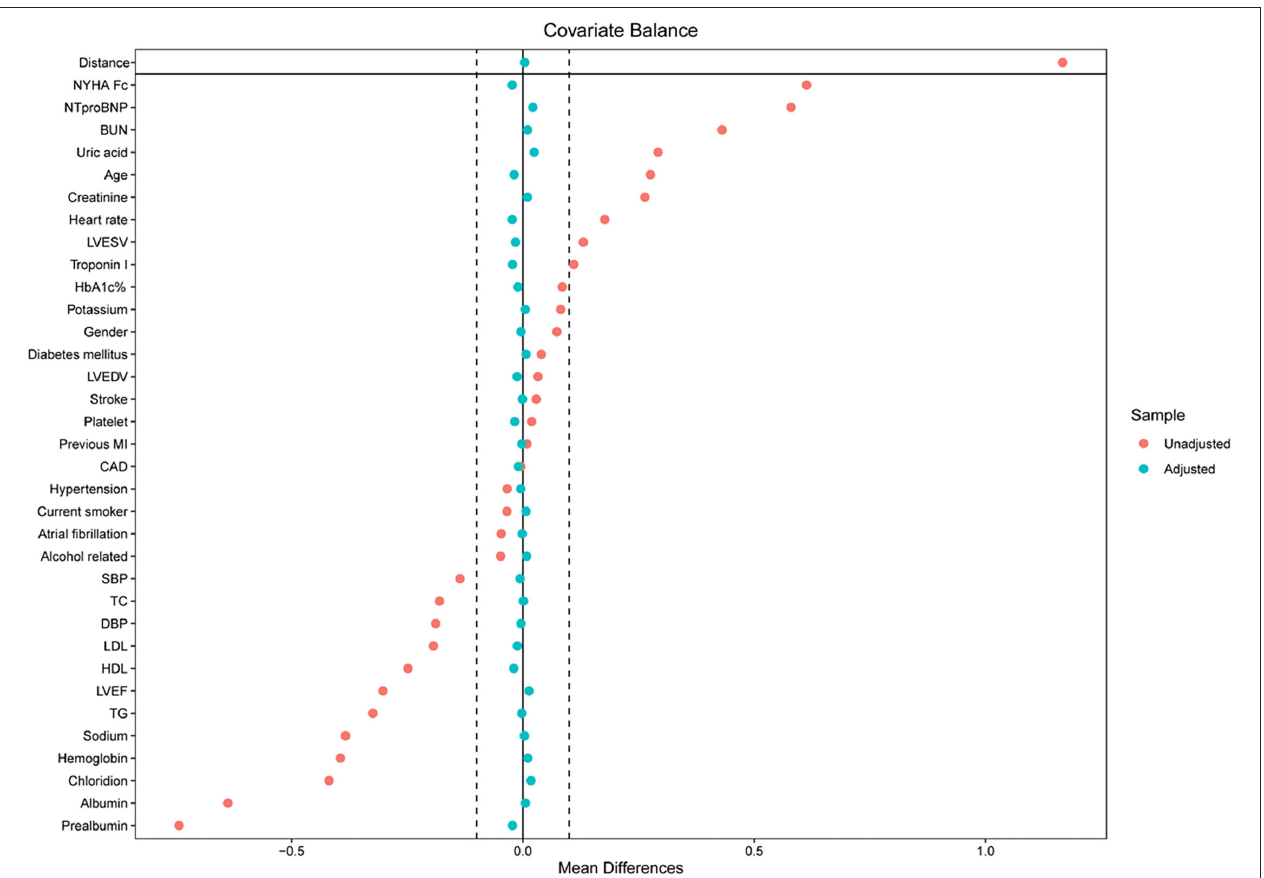
FIGURE 1 | Love plots for absolute standardized differences for baseline covariates of patients between high and low FT3/FT4 ratio group, before and after propensity score